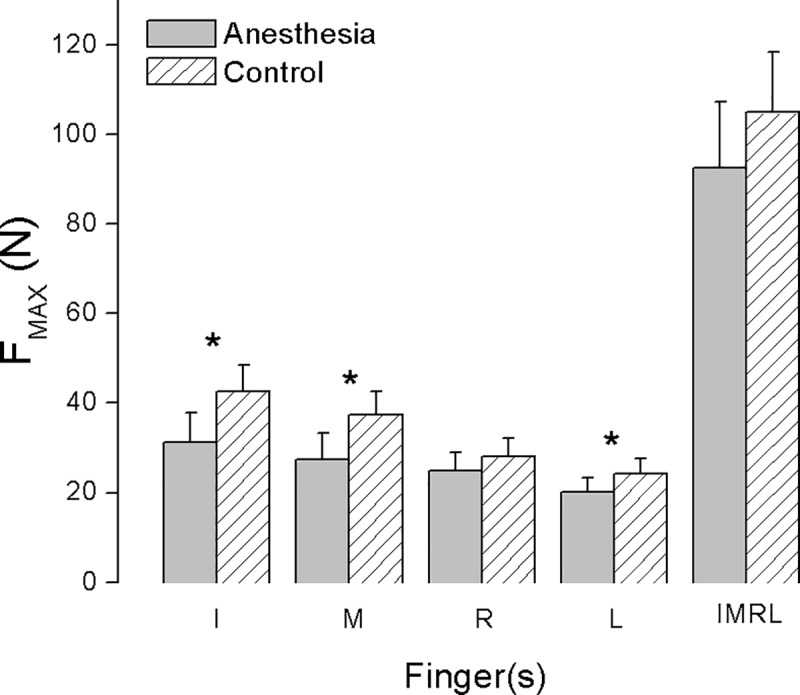
Averaged maximal pressing force in MVC task (mean ± SE).The maximal pressing force (FMAX) exerted by task-instructed fingers with I, M, R, L individually or IMRL combined, averaged across subjects in Anesthesia and control session separately. Asterisk indicates significant differences between sessions (P < 0.05).